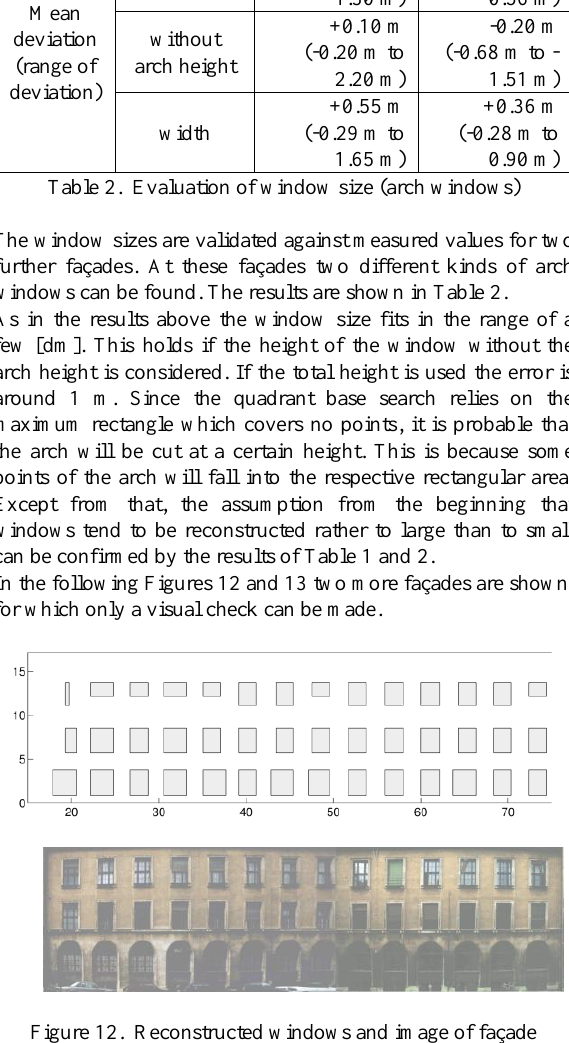
Figure 12. Reconstructed windows and image of façade